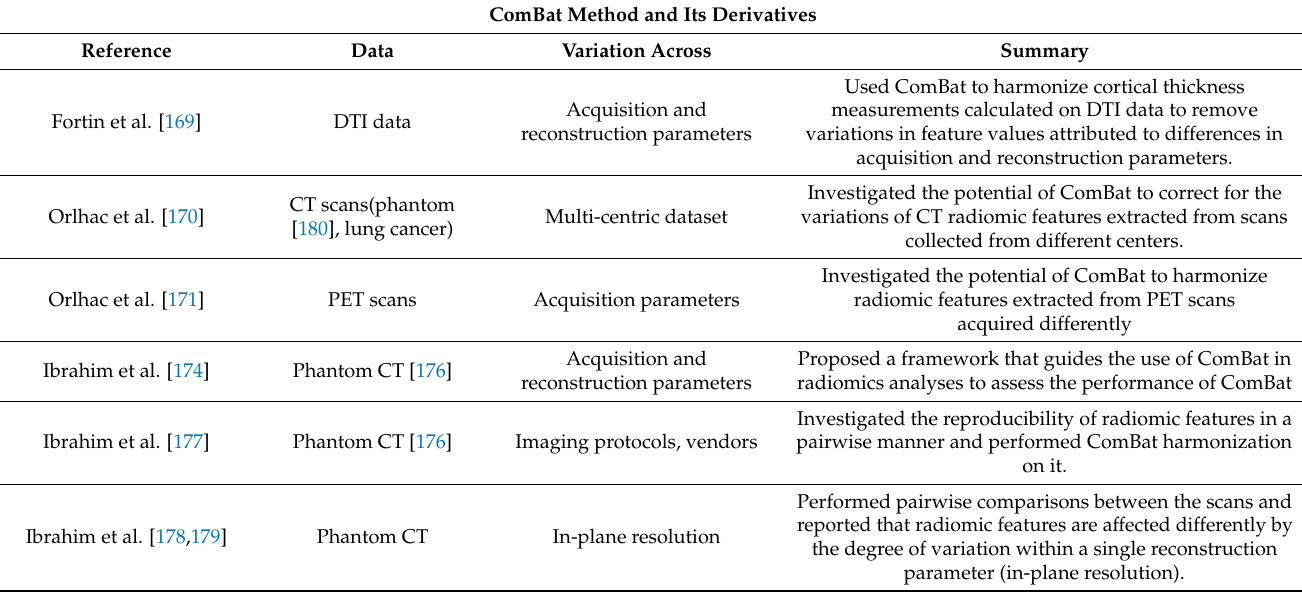
Table 8. Summary table of ComBat methods and its